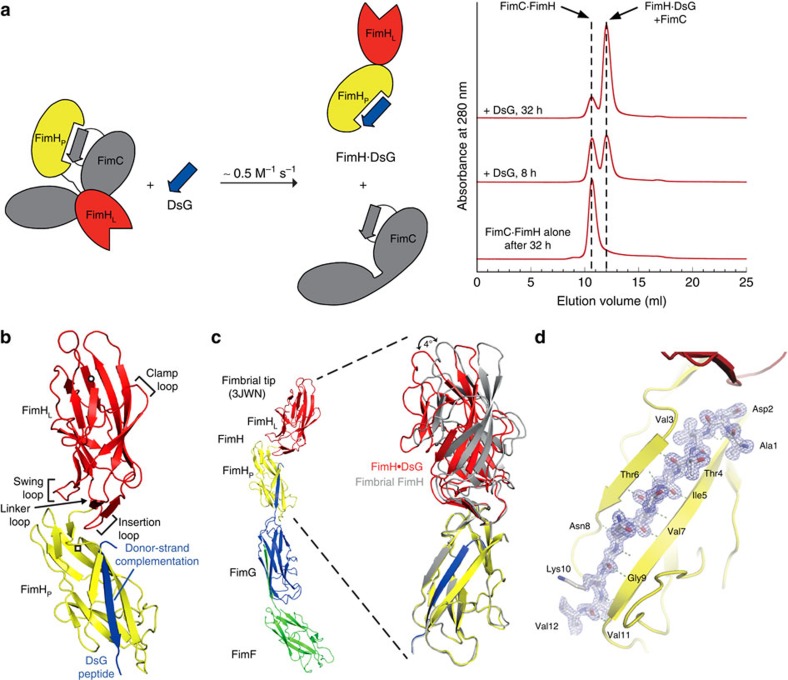
FimH·DsG resembles fimbrial tip FimH.(a) Preparation of the FimH·DsG complex by DSE. Left: reaction scheme of the DSE reaction, in which DsG displaces the FimC chaperone from the FimH pilin domain. Right: kinetics of the FimH·DsG complex formation at 37 °C, monitored by analytical gel filtration. DSE was initiated by mixing the FimC·FimH complex (15 μM) with excess DsG peptide (50 μM). Samples were removed after different incubation times, rapidly cooled on ice and immediately subjected to gel filtration. The reaction can be followed by the decrease in the FimC·FimH complex concentration and the simultaneous increase in the concentrations of FimH·DsG and free FimC (FimC and FimH·DsG coelute as a single peak at ∼12 ml). The chromatogram at the bottom shows that the FimC·FimH complex is stable against dissociation/aggregation under the chosen conditions. The rate constant of DSE estimated from these data is ∼0.5 M−1 s−1. (b) Structure of FimHF18·DsG (lectin domain FimHL, red; pilin domain FimHP, yellow; DsG, blue; circle and square indicate N- and C termini, respectively). (c) FimH from the fimbrial tip structure (left, PDB ID: 3JWN (ref. 17); FimG, blue; FimF, green) is superposed onto FimHF18·DsG based on their pilin domains (aa. 160–279), in the superposition (right) fimbrial FimH is shown in grey. (d) Close-up on the DsG peptide (stick representation) bound to FimHF18·DsG with 2Fo–Fc electron density map. Backbone hydrogen bonds of the DsG peptide and β-strands 2 (β2) and 9 (β9) of FimHP are indicated.